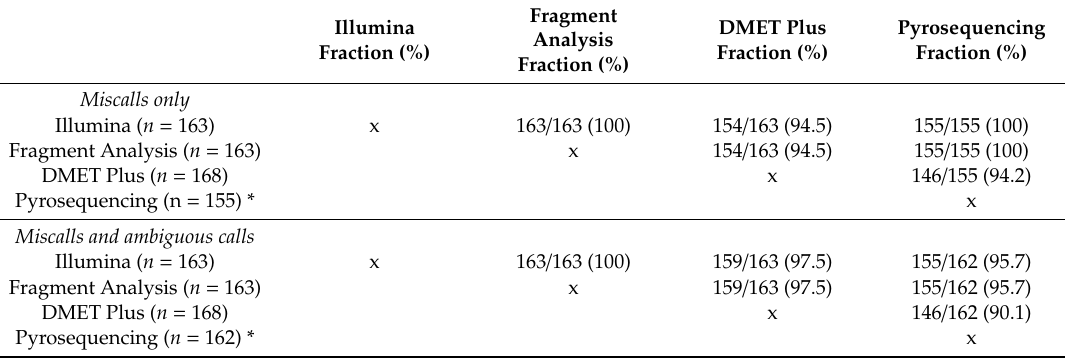
Table 3. Concordance rate among di ff erent genotyping